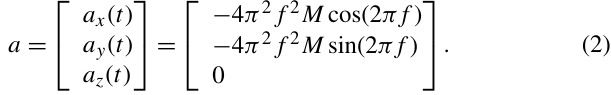
Figure 4. Tracking error for circular trajectories under various input